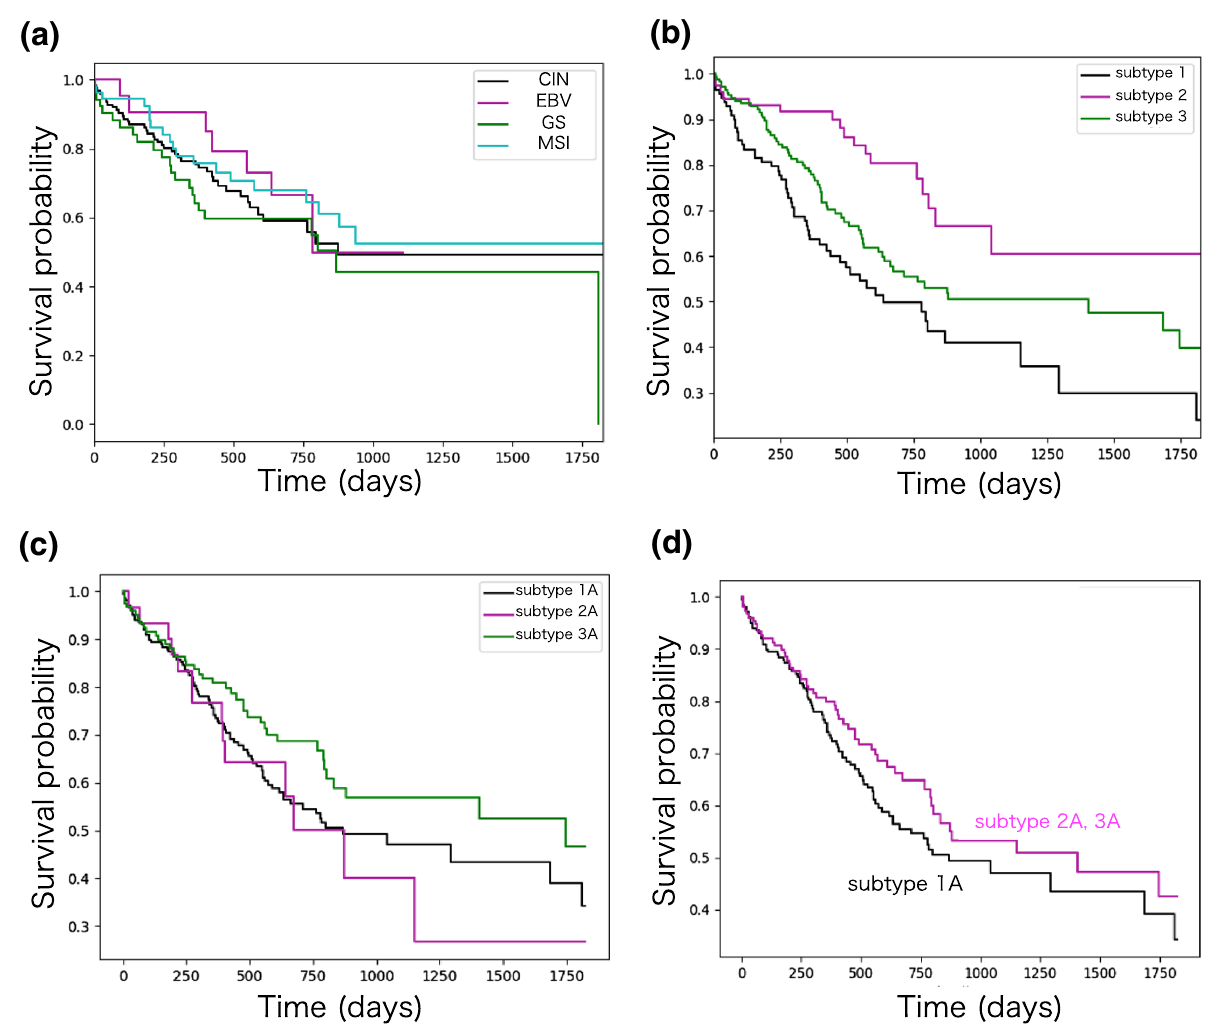
Figure 3. ( a ) Kaplan–Meier survival probability curves of patients for the multi-omics-based subtypes. The log-rank test p -value = 0.10 for the four subtypes. The log-rank test between two subtypes; 0.45 (CIN vs EBV) > 0.05, 0.30 (CIN vs GS) > 0.05, and 0.50 (CIN vs MSI) > 0.05, 0.31 (EBV vs GS) > 0.05, 0.95 (EBV vs MSI) > 0.05, 0.16 (GS vs MSI) > 0.05. ( b ) Kaplan-Meier survival probability curves of patients for the identified network- based subtypes. The log-rank test p -value = 0.00011 for the identified three subtypes. The log-rank test between two subtypes; 0.00016 (subtype 1 vs 2) < 0.05, 0.042 (subtype 1 vs 3) < 0.05, and 0.013 (subtype 2 vs 3) < 0.05. ( c ) Kaplan-Meier survival probability curves of patients for the identified RNA-seq based three subtypes. The log-rank test p -value = 0.06 for the identified three subtypes. The log-rank test between two subtypes; 0.70 (subtype 1 vs 2) > 0.05, 0.091 (subtype 1 vs 3) > 0.05, and 0.14 (subtype 2 vs 3) > 0.05. ( d ) Kaplan-Meier survival probability curves of patients for the identified RNA-seq based two major subtypes. The log-rank test p -value = 0.19 >